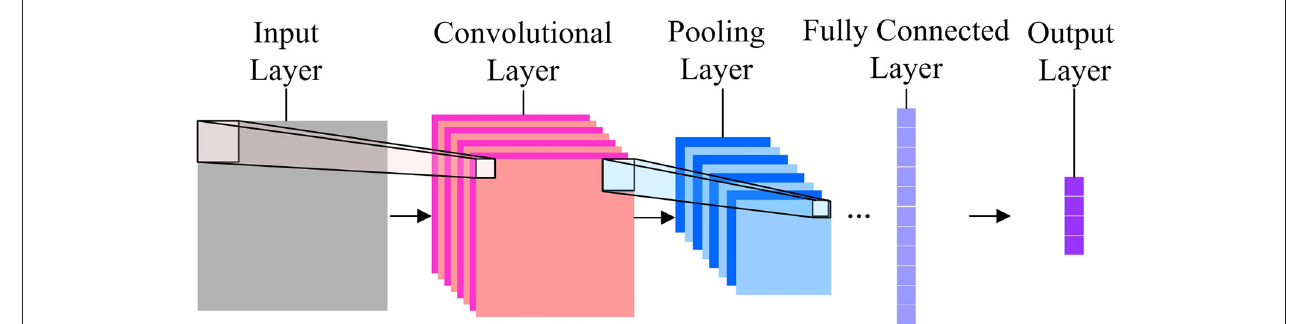
FIGURE 1 | The General structure of a